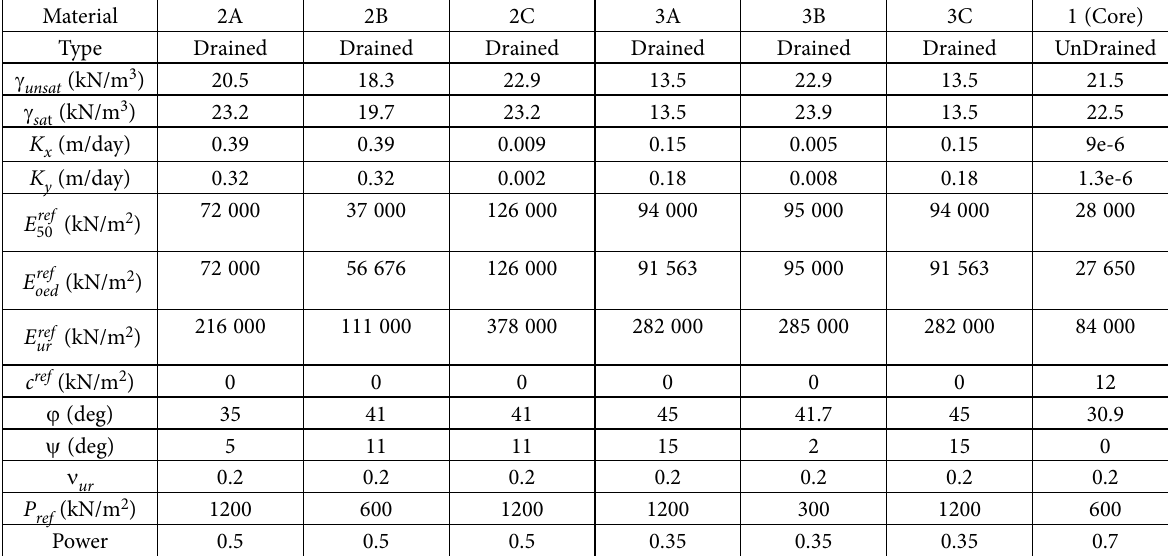
Fig. 9. 260 Cross section of Masjed Soleiman Dam(A), Meshed dam(B), Shear strain (C), Shear strain along line AA*(D) Table 1. Material property of dam body in HS